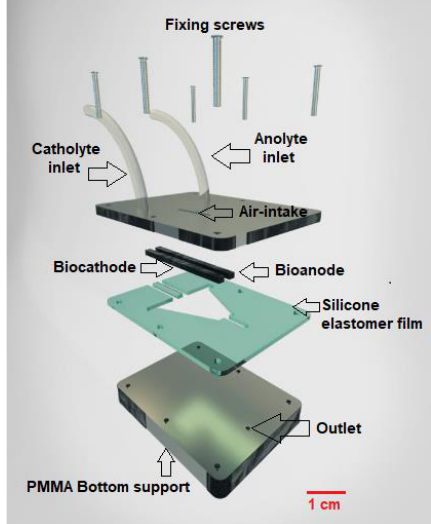
Figure 13. Diagram of the microfluidic cell used in this work.